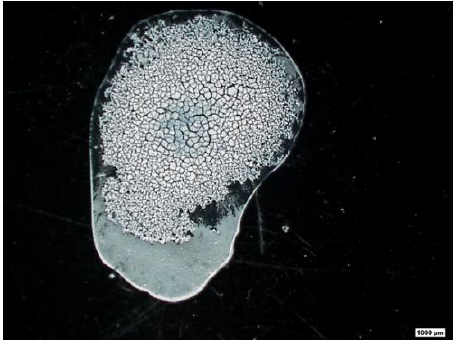
Figure 9—SiO drop on glass. The bar shown is 1000 µm. Initial concentration of silica is 0.40 weight 2